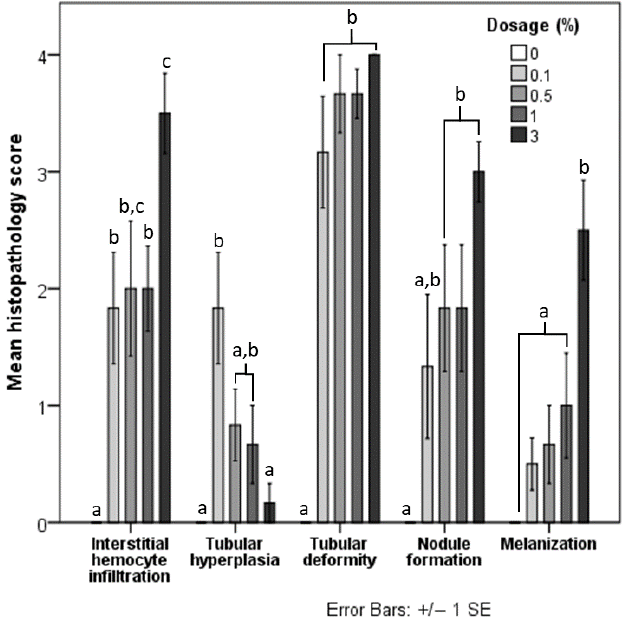
Figure 3. Mean histopathological score of each lesion in shrimp fed with five different doses of HDPE microplastics. Different letters (a, b, and c) above bars of the same series indicate significant differences in the mean histopathological score between the different doses ( p < 0.05).